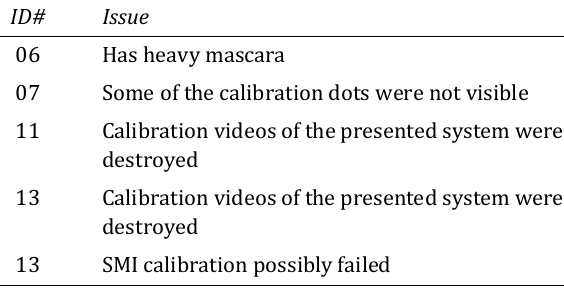
Figure 13 exemplifies a gaze tracking signal, blink events, and sigmoid values of Eq. (2), estimated from a video material recorded during the saccade and smooth pursuit tasks. The signal seems to behave smoothly during fixations, as expected from the utilized Bayesian tracking algorithms and Kalman filtering. On the other hand, the signal succeeds to follow the saccadic behavior without an “overshooting" effect, owing to the modified measurement variance of the Kalman filter. Also the sigmoid